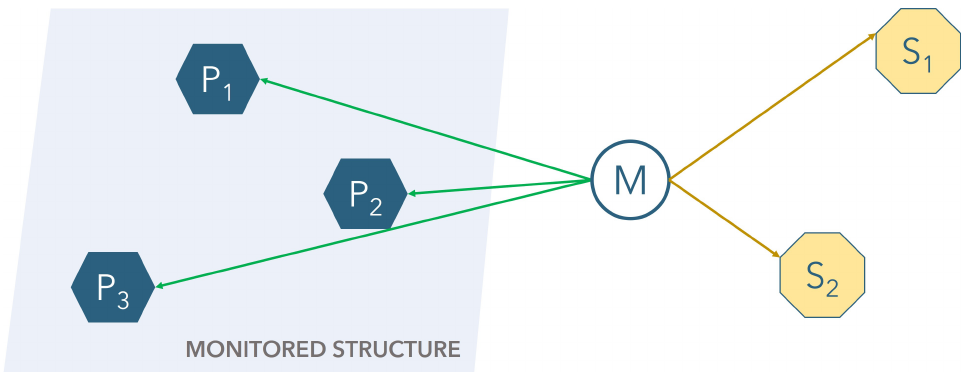
Figure 1. The star-shaped design of a monitoring network; M master station; P 1 , P 2 , P 3 monitored points; and S 1 , S 2 permanent stations of a global positioning